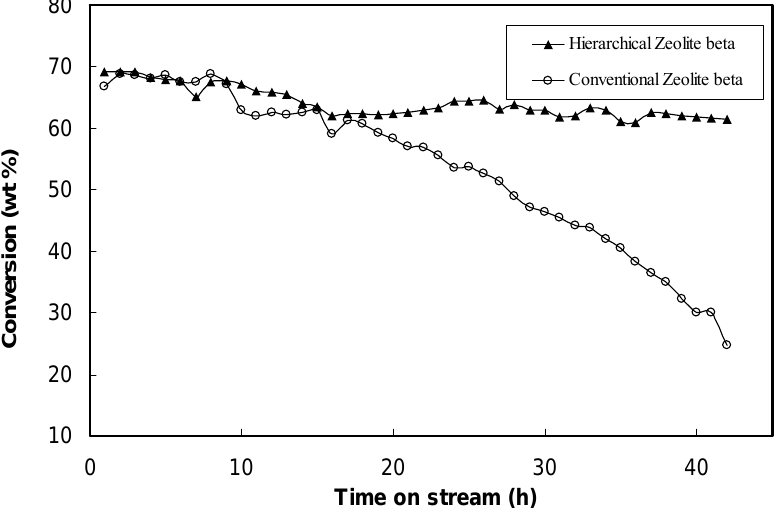
Figure 7. Deactivation behavior of mesoporous zeolite beta and conventional zeolite beta for the cracking of 1,2,4-trimethylbenzene at 350 °C. Adapted from Reference